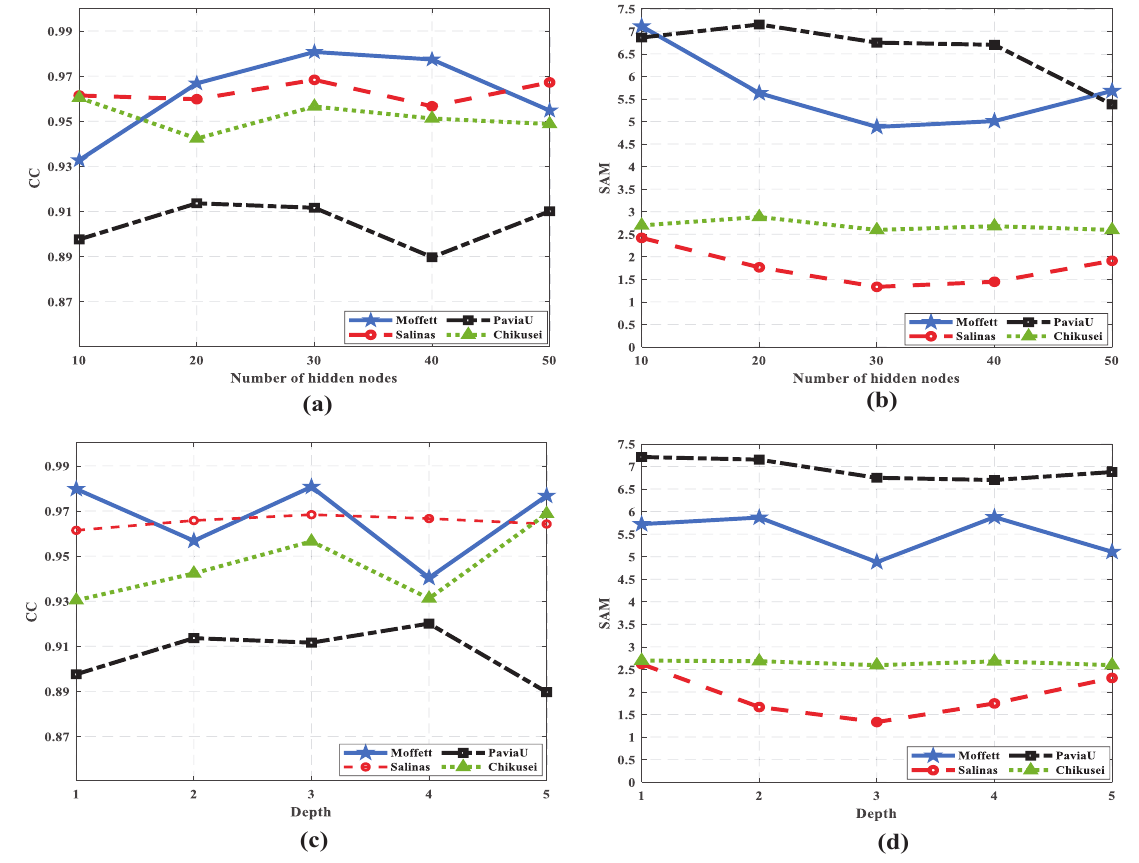
Figure 3. CC and SAM curves as functions of the number of hidden nodes and depth for the Moffett Field, Salinas Scene, Pavia University, and Chikusei data sets.